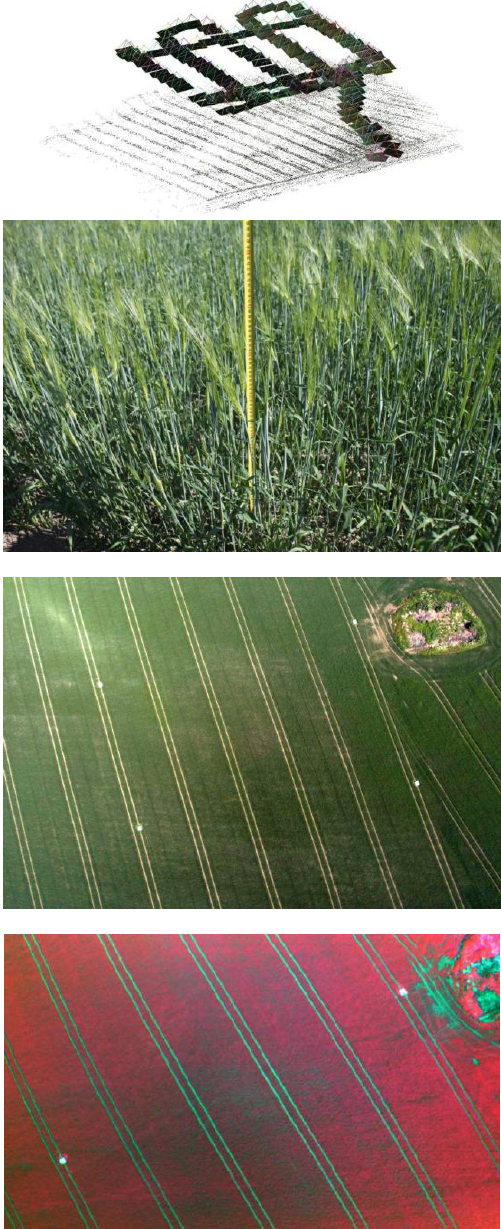
Fugure 6. Traceable UAV campaign in Vihti agricultural test field. From top: the image block with five vertical flight lines and two crossing flight lines; ground view; sample RGB image; sample FPI